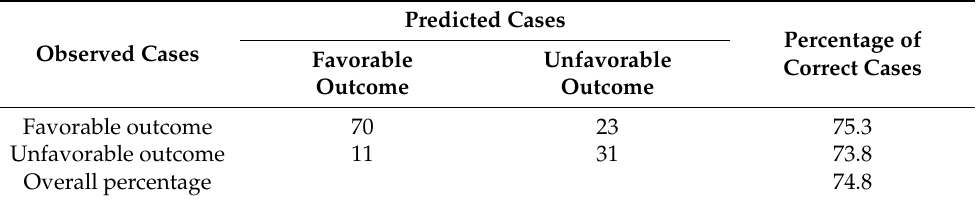
Table 5. Prognostic value of the model for predicting clinical outcome in CC